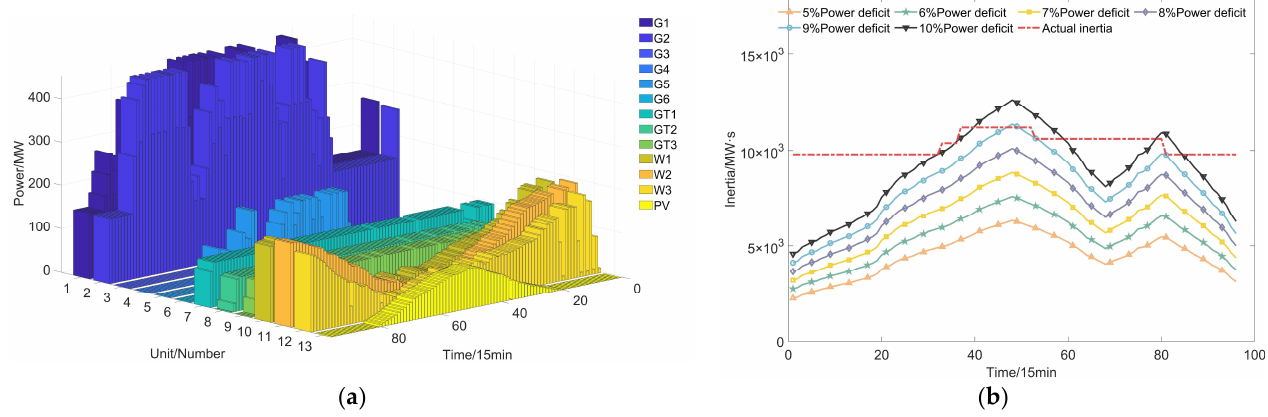
Figure 4. ( a ) Results for intraday scheduling. ( b ) Inertia demand for different power deficits in the intraday scheduling period.